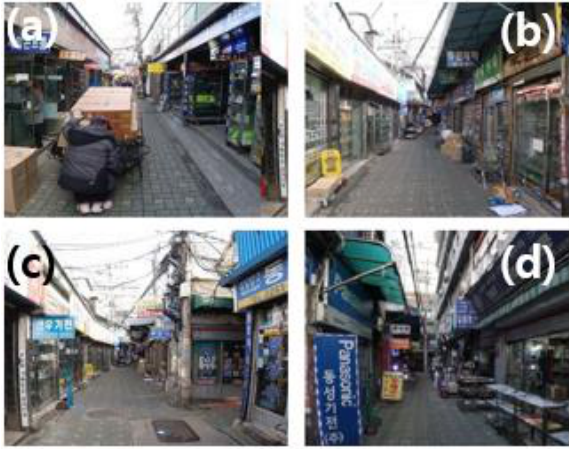
Figure 2. 4 pictures are the view of the alleyway. As you can see in pictures, the width of the road is very narrow.